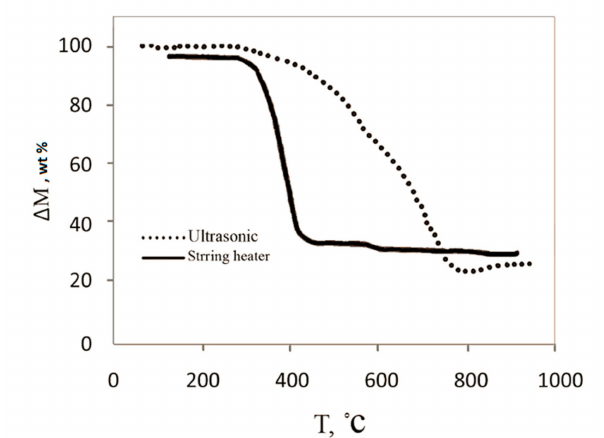
Figure 3. TGA data for pristine CNTs by using ultrasonic bath and stirring heater as two dispersion